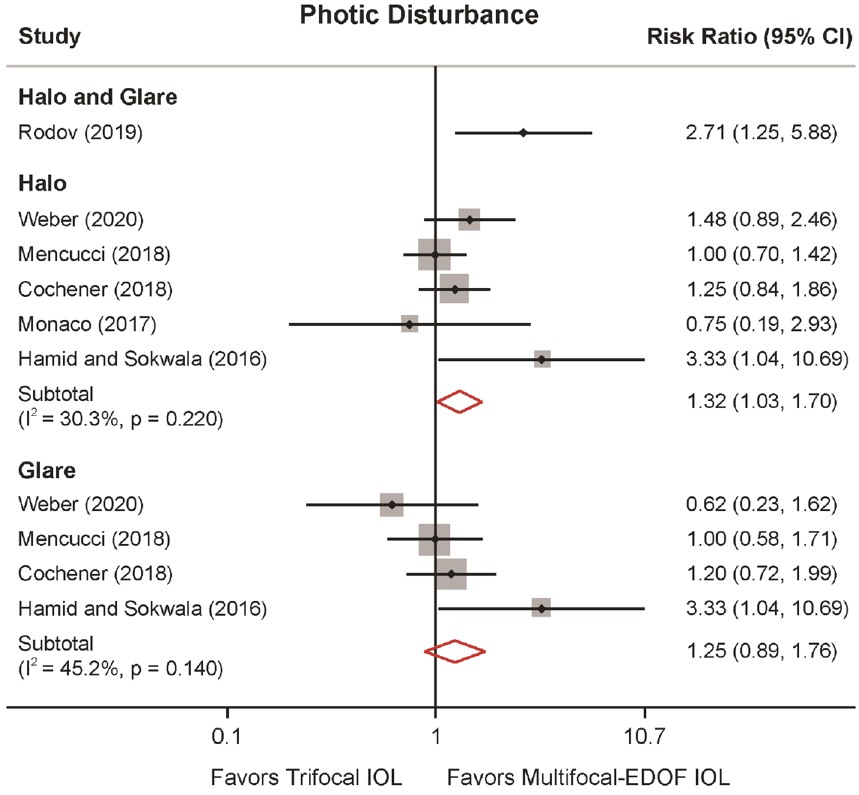
Figure 5. Photic disturbance of halo and glare comparing trifocal and the hybrid multifocal-extended depth of focus (EDOF) intraocular lens (IOL).